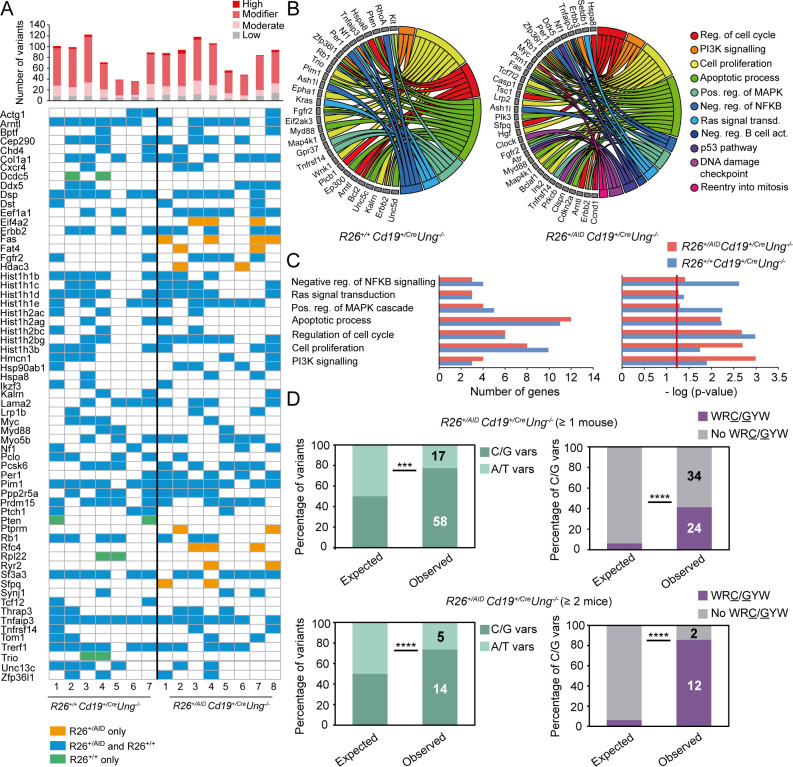
AID broadens the functional impact of oncogenic events in UNG deficient tumors.(A) Cancer-related genes found mutated in tumors from R26+/+Cd19+/creUng-/- and R26+/AIDCd19+/creUng-/- mice. Upper panel shows total number of variants identified in all cancer-related genes in each of the tumors; color code defines the functional impact of the variants as annotated by Variant Effect Predictor (VEP; see methods section for details). Lower panel represents presence (colored box) or absence (empty box) of variants in each of the cancer-related genes for each of the analyzed tumors. For simplicity, only mutated genes found in > = 2 tumors per group are shown; a full list is included in S3 Table. Green indicates genes exclusively mutated in R26+/+Cd19+/creUng-/- tumors; orange indicates genes exclusively mutated in R26+/AIDCd19+/creUng-/- tumors; blue indicates genes mutated in both. (B) Circos plot representation of the biological functions associated to all mutated cancer-related genes (Gene Ontology biological process database) in R26+/+Cd19+/creUng-/- (left) and R26+/AIDCd19+/creUng-/- (right) tumors. (C) Number of genes (left) and p-value of the enrichment (right, EASE score -modified Fisher exact test- as provided by DAVID, see methods for details) of the common biological functions affected in both R26+/+Cd19+/creUng-/- and R26+/AIDCd19+/creUng-/- tumors. (D) Proportion of mutations in C/G and A/T nucleotides (left) and within WRC/GYW hotspots (right) in cancer-related genes that are exclusively mutated in R26+/AIDCd19+/creUng-/- tumors (Fisher two-tailed test; ****p≤10−4).